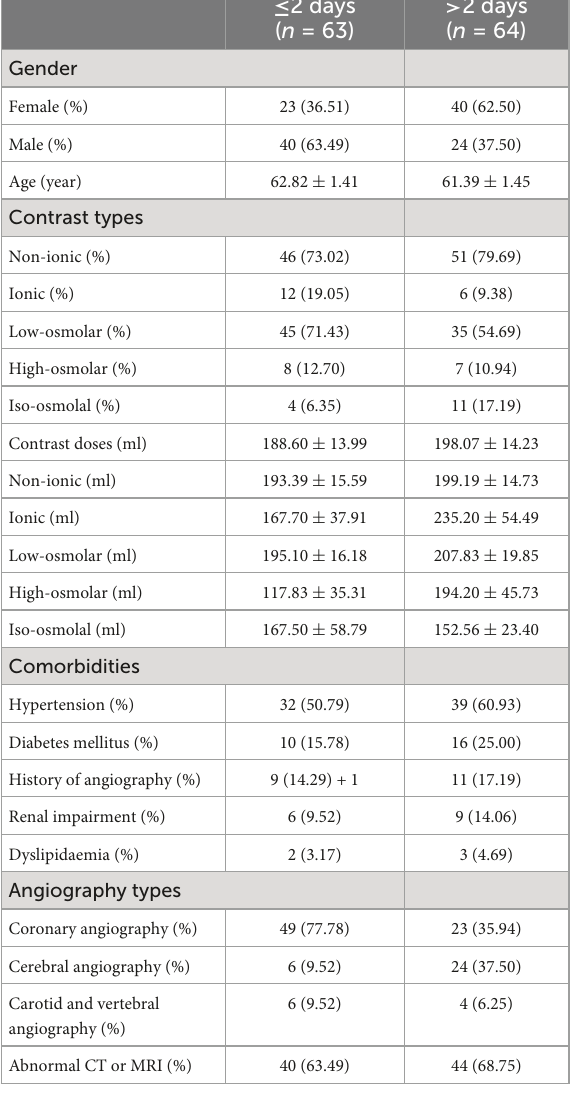
TABLE 2 The relationship between prognosis with